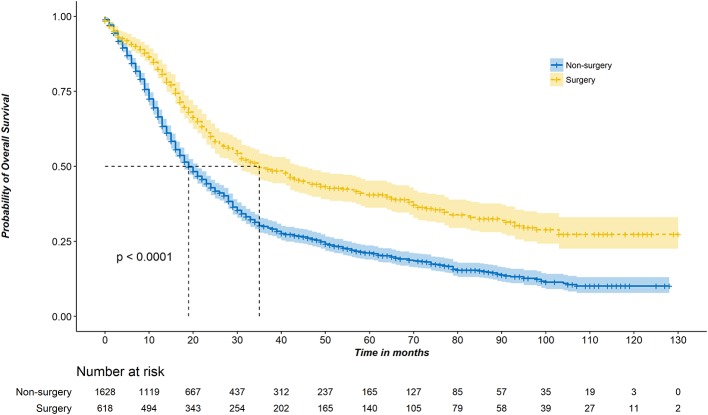
Kaplan–Meier survival curves for IA–IIB stage SCLC patients with or without surgery.